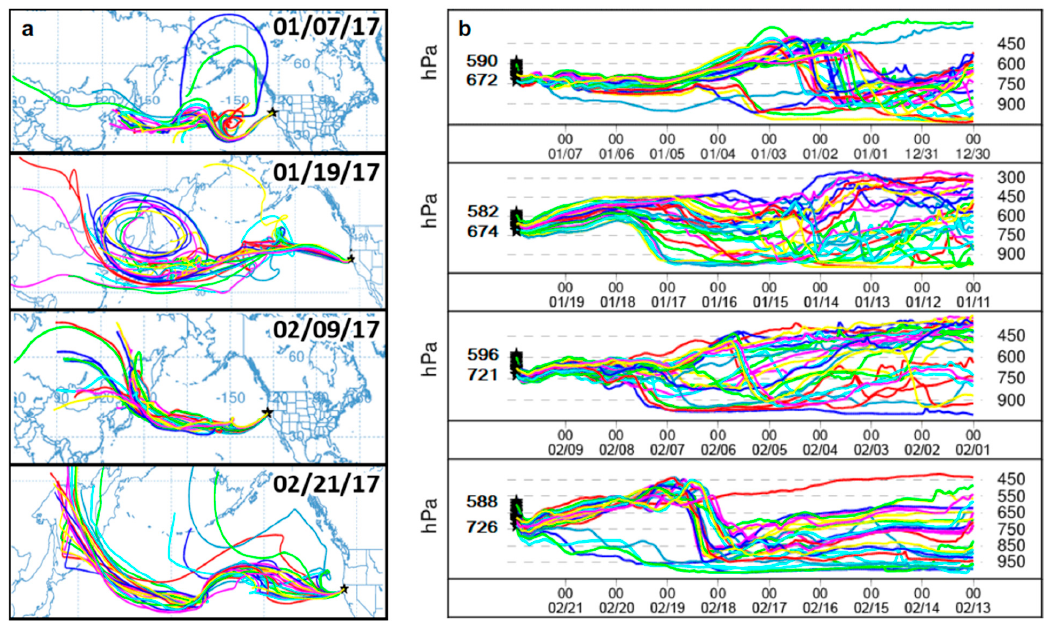
Figure 10. HYSPLIT back trajectories at Redwood NP for ( a ) back trajectories calculated at the first day of 2017 AR events. ( b ) 10-day back trajectories (day 0 to day − 9, from left to right) at different heights (hPa).